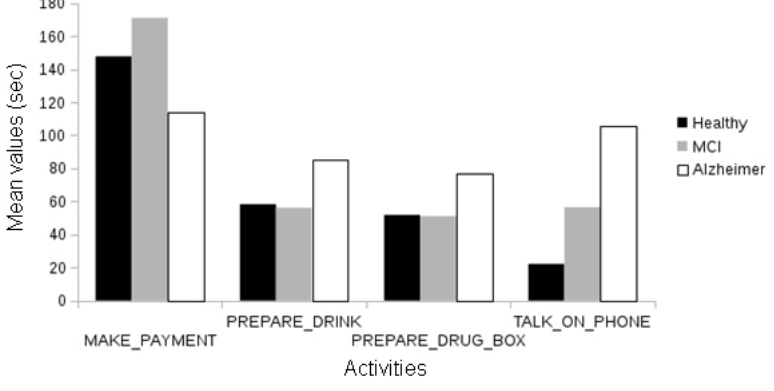
Figure 11. Comparison between the duration of manually annotated events of the different cognitive status groups of the Thessaloniki pilot.